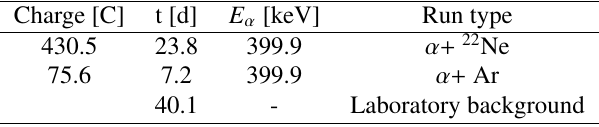
Table 2: Experimental campaign II. Charge Q, running time t in days and beam energy for on-resonance measurements ( α + 22 Ne), beam induced background runs ( α + Ar) and for no- beam background are